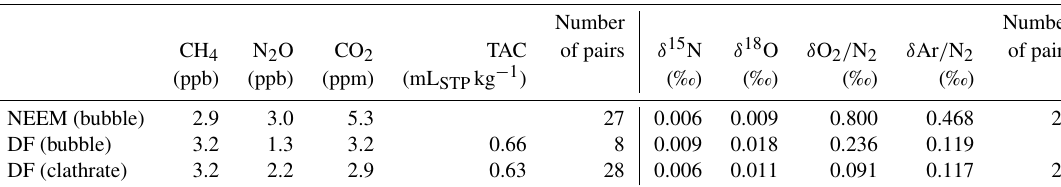
Table 7. Pooled SDs for the NEEM and Dome Fuji ice cores.